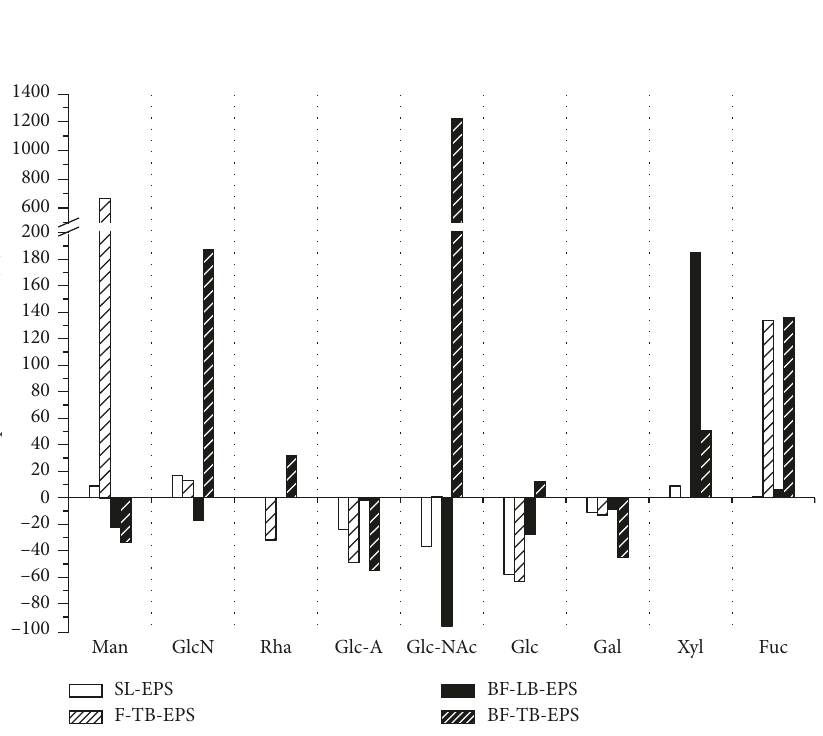
Table 3: Monosaccharide composition for EPS fractions prepared from untreated diatom Stauroneis sp. Fractions